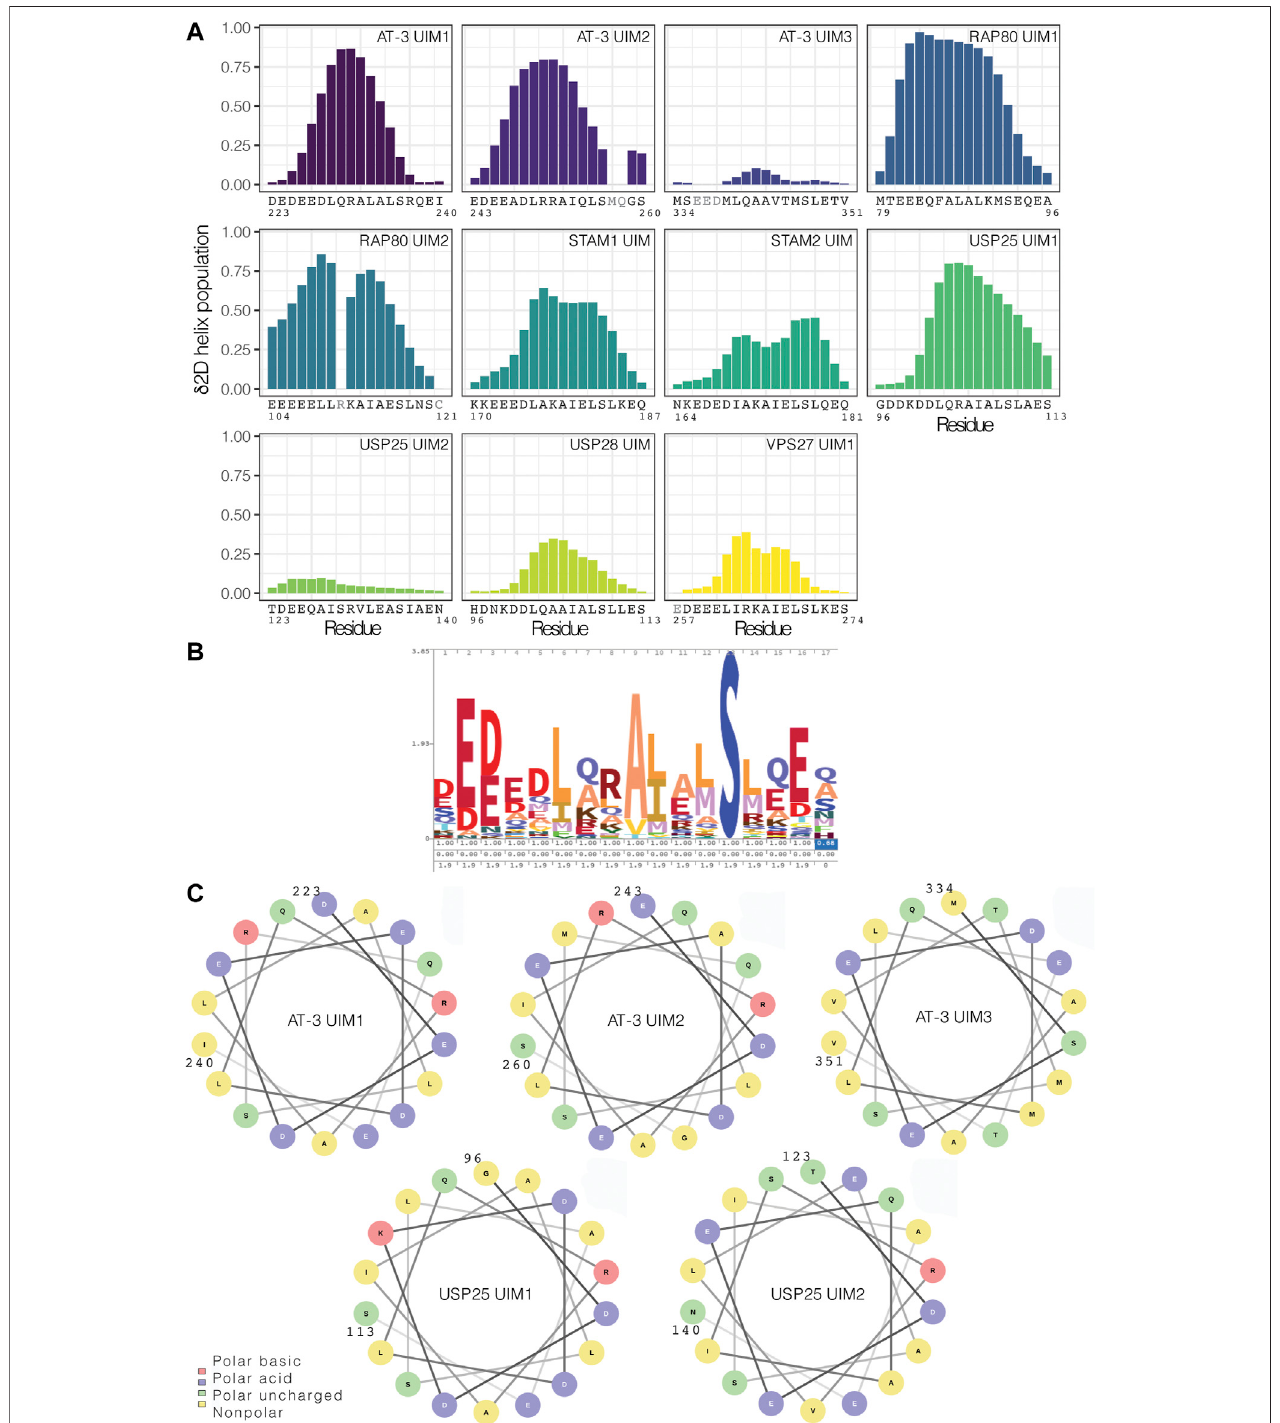
FIGURE 7 | UIMs in the free state can vary from highly helical conformations to disordered counterparts. (A) Helical content for the UIMs predicted from chemical shiftsby δ 2D.WeusedninesetsofreleasedchemicalshiftsofUIMsinthefreestateinsolutionfromtheBMRBdatabase,includingAT-3UIM3,STAM1UIM,STAM2UIM, USP28UIM, USP25UIM1, andUIM2,andRAP80 UIM1andUIM2.Wealsousedaset ofreleasedchemicalshiftsofVPS27UIM1infusionwiththeubiquitin.Inaddition, we used the NMR chemical shifts that we recorded for AT-3 182-291 UIM1 and UIM2. We highlighted in gray the residues for which there are not enough chemical shifts to run the prediction with δ 2D. UIMs have a wide range of predicted helical content. (B) Consensus sequence for UIMs in the PFAM database. (C) Helical wheel representation of AT-3 UIM1, UIM2, and UIM3, and of USP25 UIM1 and UIM2.